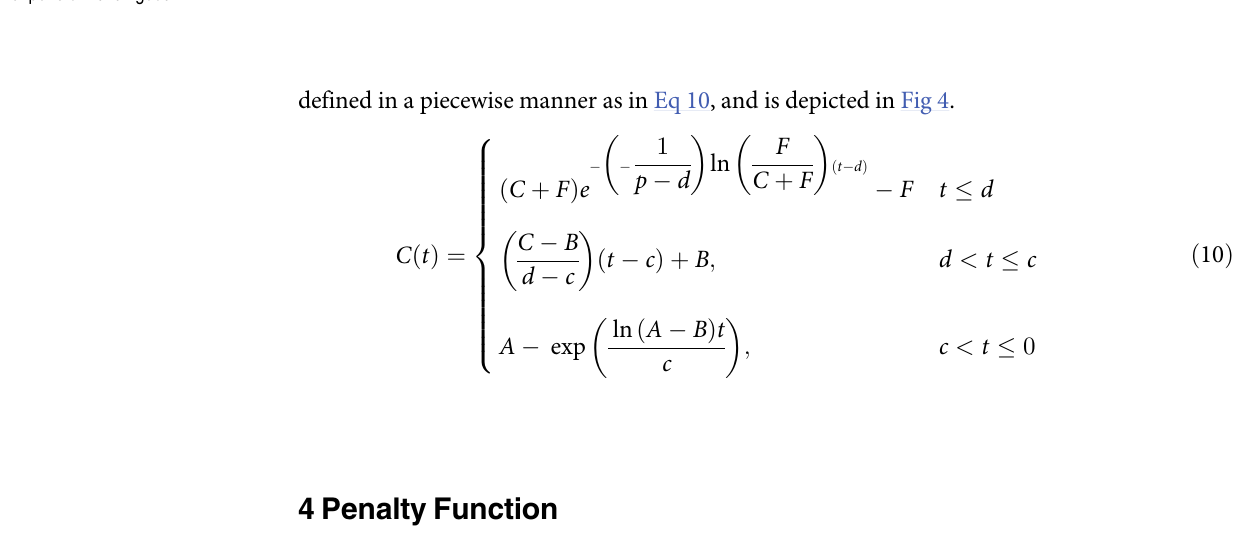
Fig 3. The Cost-Benefit Curve for Scenario 2.